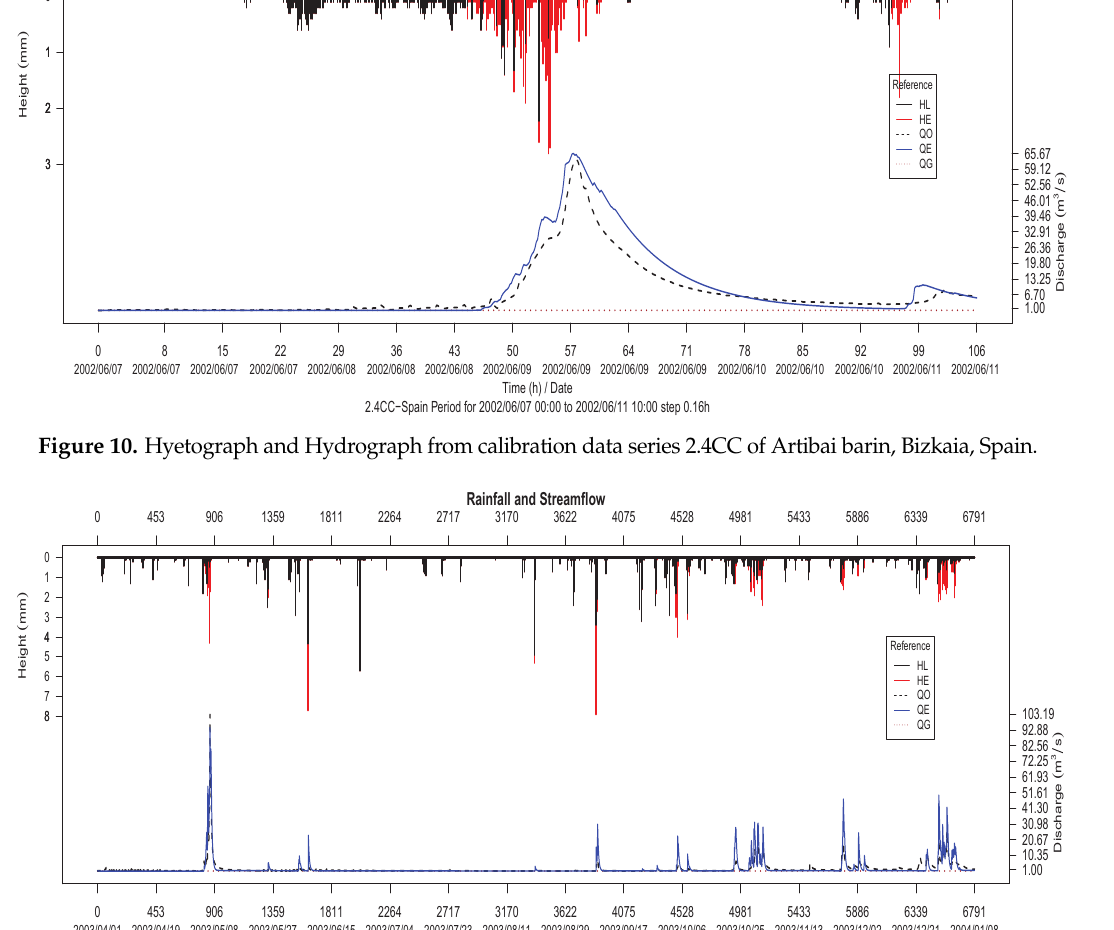
0.16hTime (h) / 2.3CV−Spain Period for 2003/04/01 00:00 to 2004/01/08 23:00 step Figure 11. Hyetograph and Hydrograph from validation data series 2.3CV of Artibai barin, Bizkaia, Spain.